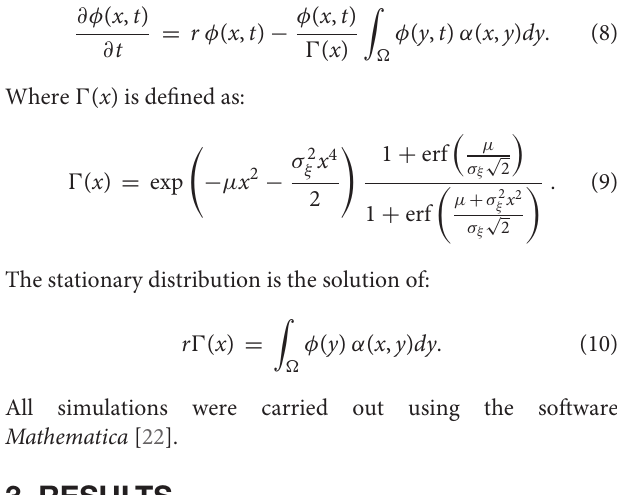
( Figure 1A ), we set competition and carrying capacity functions parameters as: a 2 and µ 1. Recall that under = =